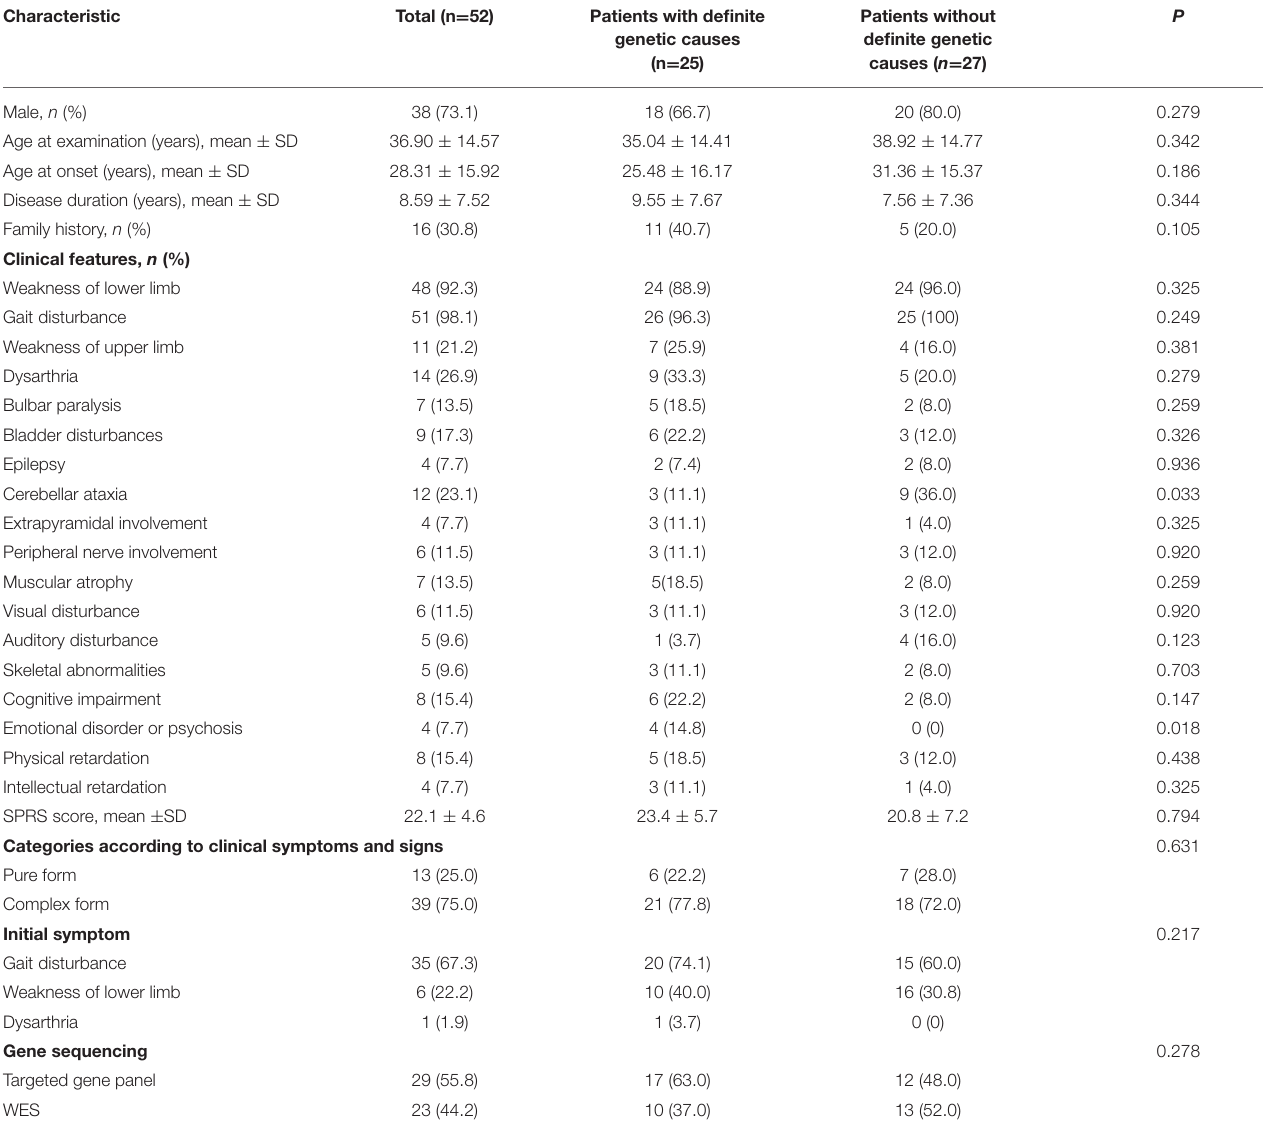
TABLE 2 | Characteristics of the patients with clinically suspected hereditary spastic paraplegia. Characteristic Total (n = 52) Patients with definite